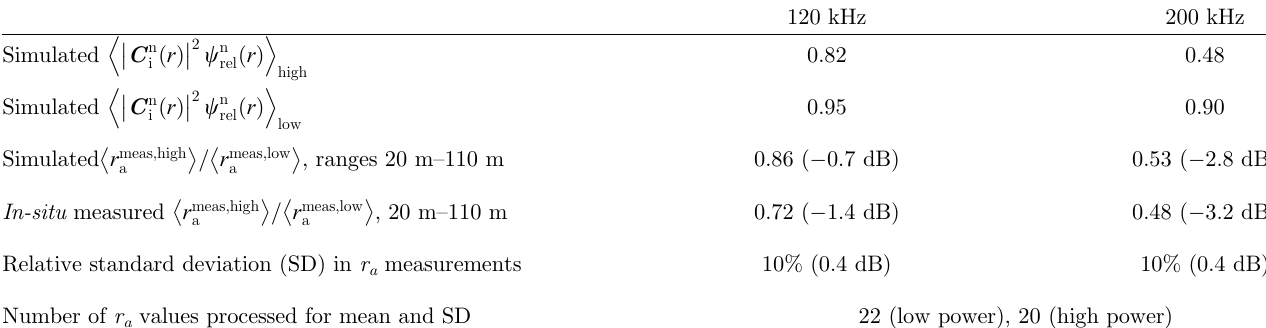
ð r Þj 2 (cid:5) w n ð r ÞÞ (cid:3) 1 , representing the integrated nonlinear loss over the sound beam Figure 3. (a) Numerically calculated values for ðj C n rel i and thus the nonlinear loss in the s v measurement. The parameters in Table 1 were used for the calculations. (b) Numerical and experimental values for the ratio r meas ; high a = r meas ; low a between volume backscattering measurements using the “ high ” and “ low ” power settings. The experimental data are divided in depth bins with 20 m width, indicating mean values and standard deviations for the 11-hour measurement series. Table 2. Summary of simulation and measurement